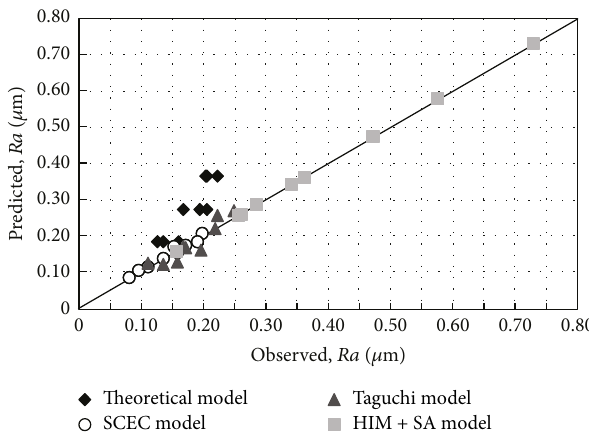
Figure 9: Comparison between observed versus predicted for the studied